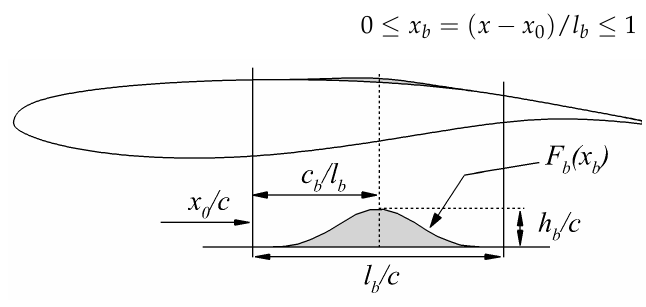
Figure 2. The definition of shock control bump relative to the OAT15A airfoil.